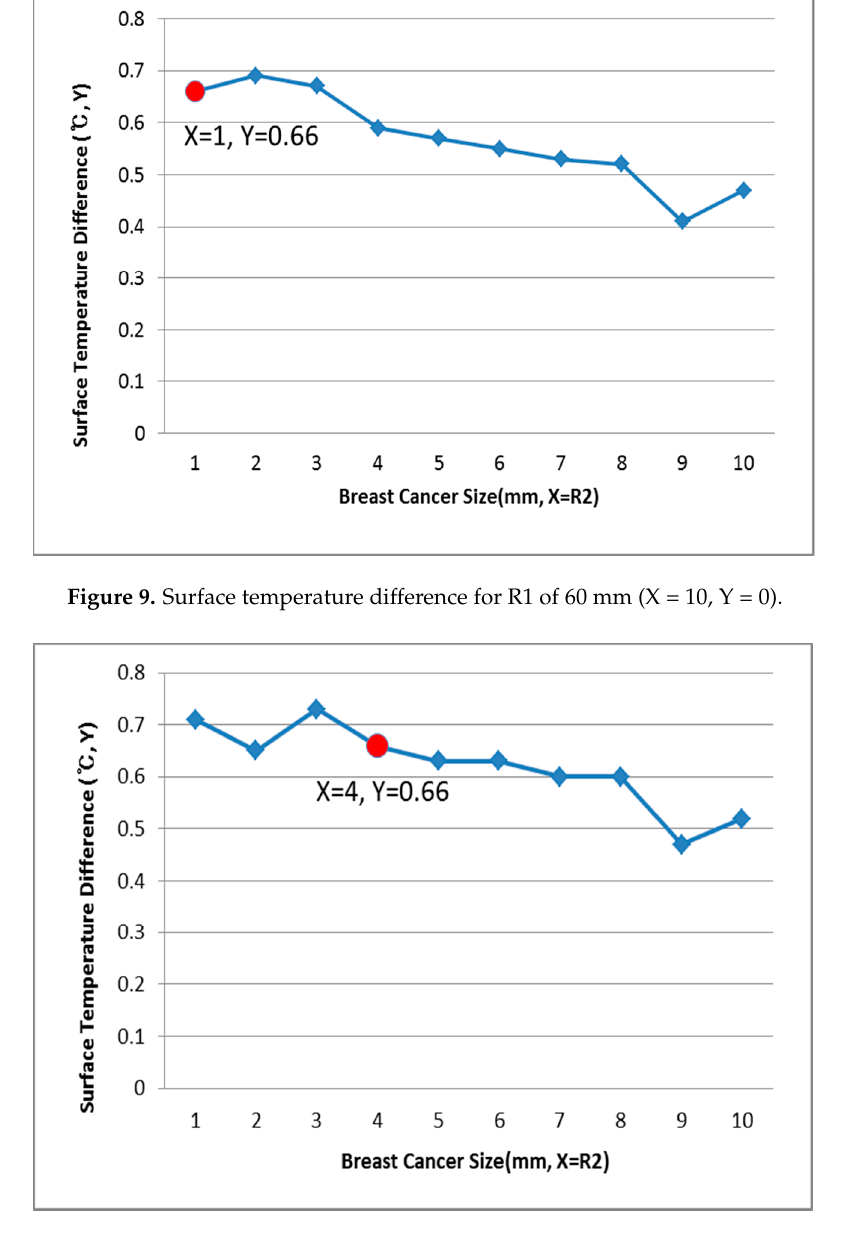
Figure 10. Surface temperature difference for R1 of 70 mm (X = 10, Y = 0).